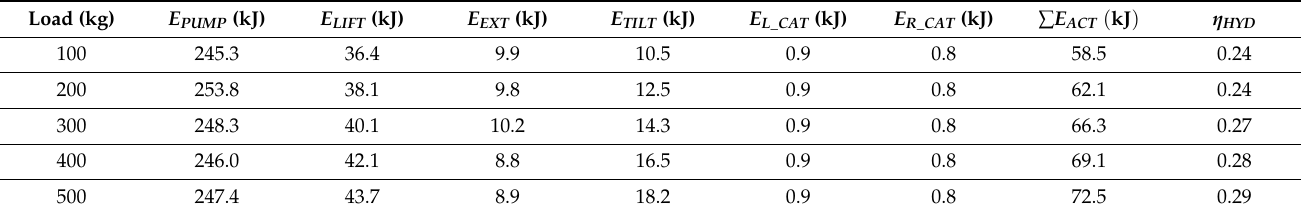
Table 3. Energy supplied, energy demanded and hydraulic efficiency for each load condition.